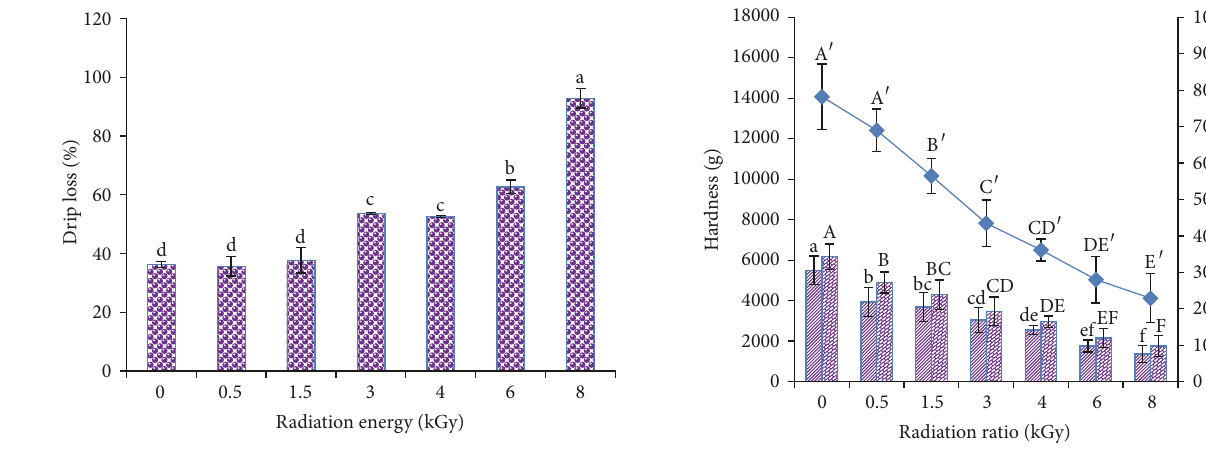
Figure 2: Effect of irradiation on drip loss of SBJ. Values are represented as mean ± SD. Significance was tested by Duncan Multiple Range Test at 𝑃 < 0.05 , and values with the same superscript were found not significantly different from each other. ( 𝑅 2 = 0.959 ). Similar tendency appeared as the pork fillet [40] and pork loins were irradiated [41].